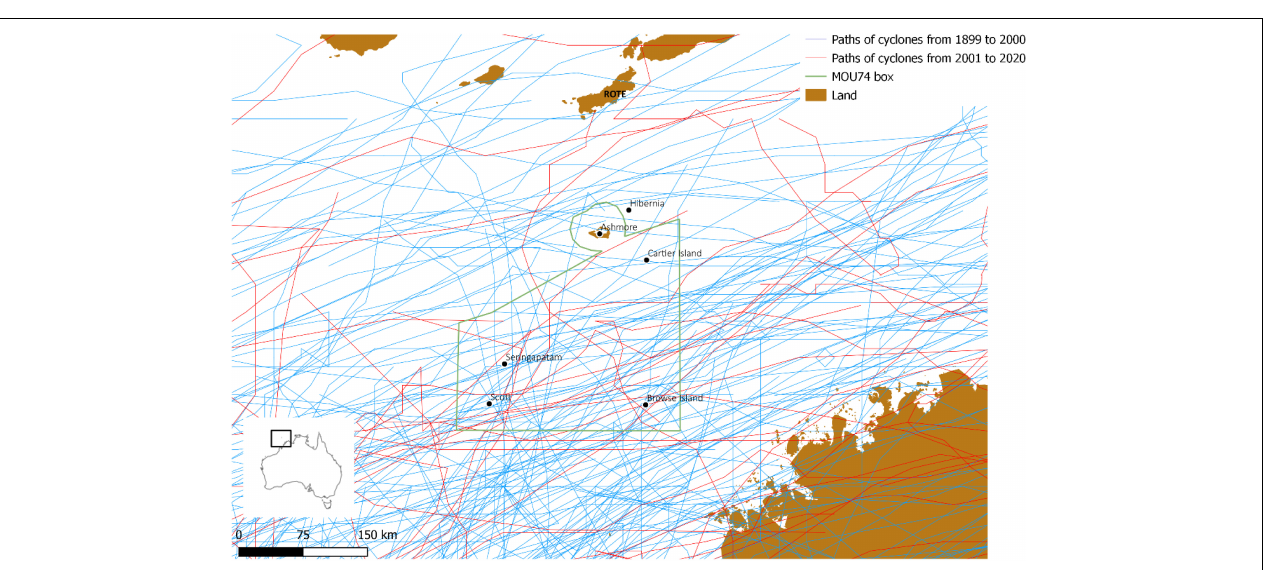
FIGURE 2 | Paths of cyclones over the Timor Sea between 1899 and 2020 and the location of reefs. Tropical Cyclone Linda in 1976 was the only cyclone that was mapped with a direct path over Ashmore Reef Marine